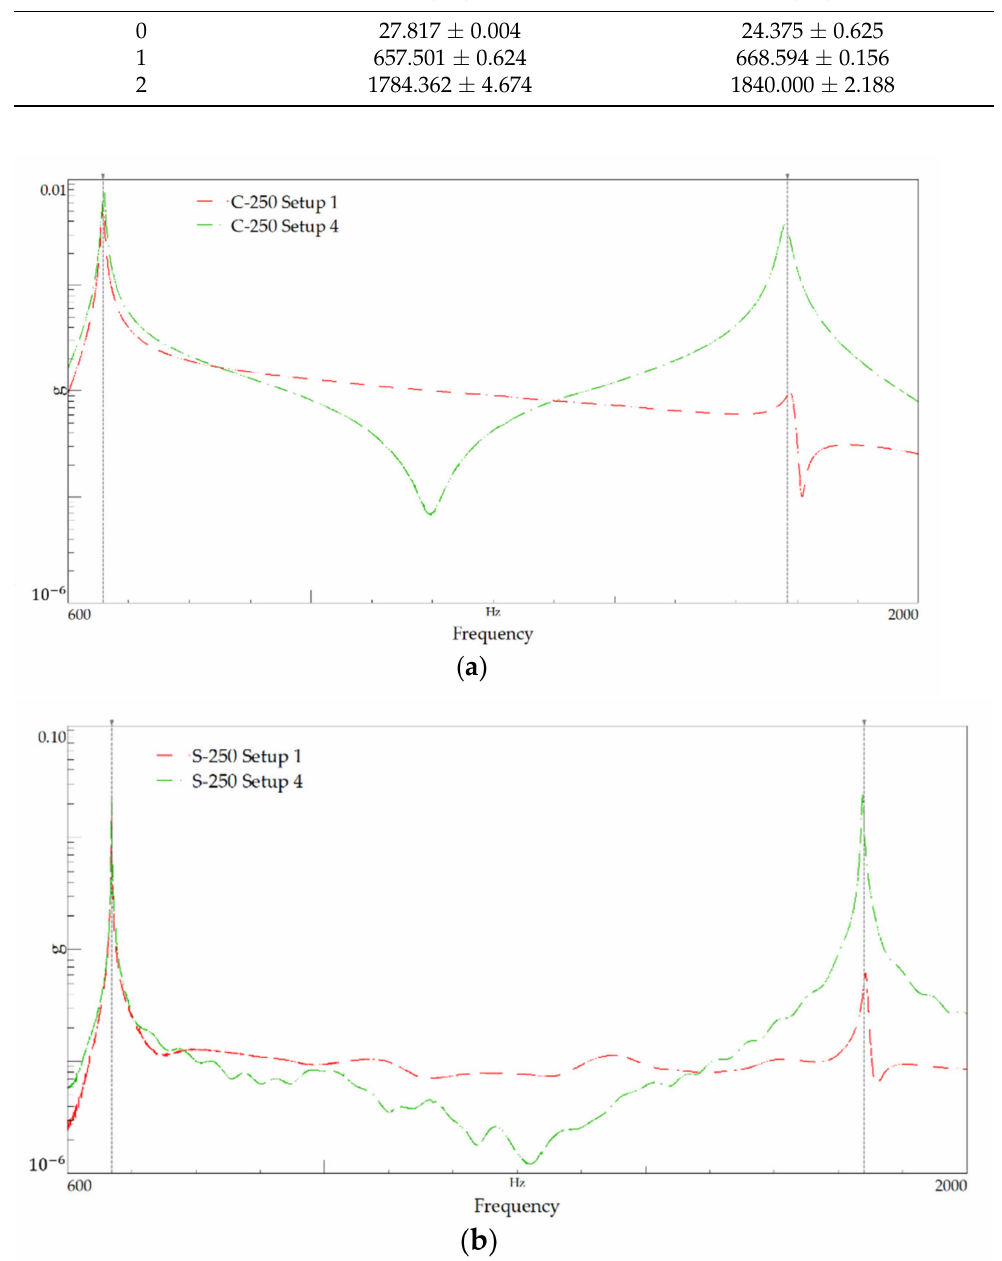
Figure 15. Power spectral density plot for the 250 mm-length: ( a ) C-250 and ( b )